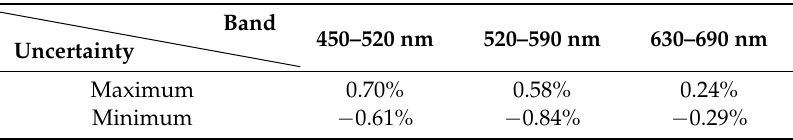
Table 6. Maximum and minimum value of σ i induced by chlorophyll concentration measurement errors in the 22 samples.